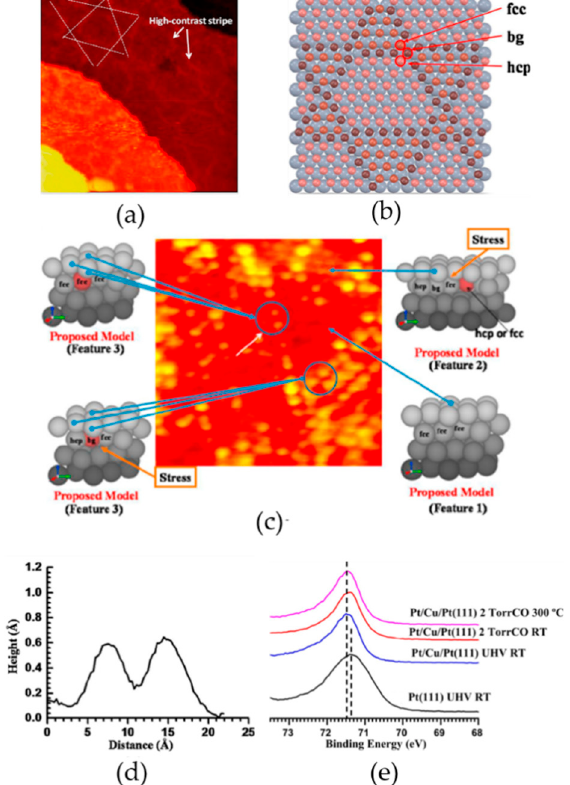
Figure 10. ( a ) STM image of the Pt/Cu/Pt (111) surface under UHV. A basic structure marked by white lines forms high-contrast stripes, which is clearly shown in ( a ). ( b ) Structural model of the Pt/Cu/Pt (111) surface for the formation of stripes. The first layer of atoms is neglected, and dark yellow and brown atoms are the second layer (the alloy layer), in which atoms are either Cu or Pt. Light blue atoms are the third layer of the structure. ( c ) Atom-resolved visualization STM image of Pt/Cu/Pt (111) NSA with a size of 75 × 75 Ǻ at room temperature under UHV. ( d ) Line profile of the section marked with a white arrow in ( c ). ( e ) Pt 4f spectra of Pt (111) and Pt/Cu/Pt (111). From bottom to top: in UHV at RT, in UHV at RT, under 2 Torr of CO at RT, and under 2 Torr of CO at 300 °C.